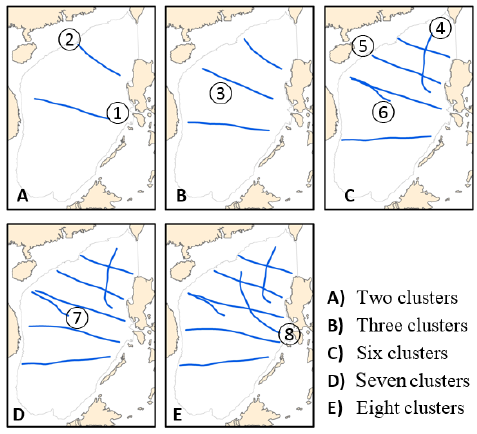
Figure 4. Average similarity index with various numbers of clusters using FCM.